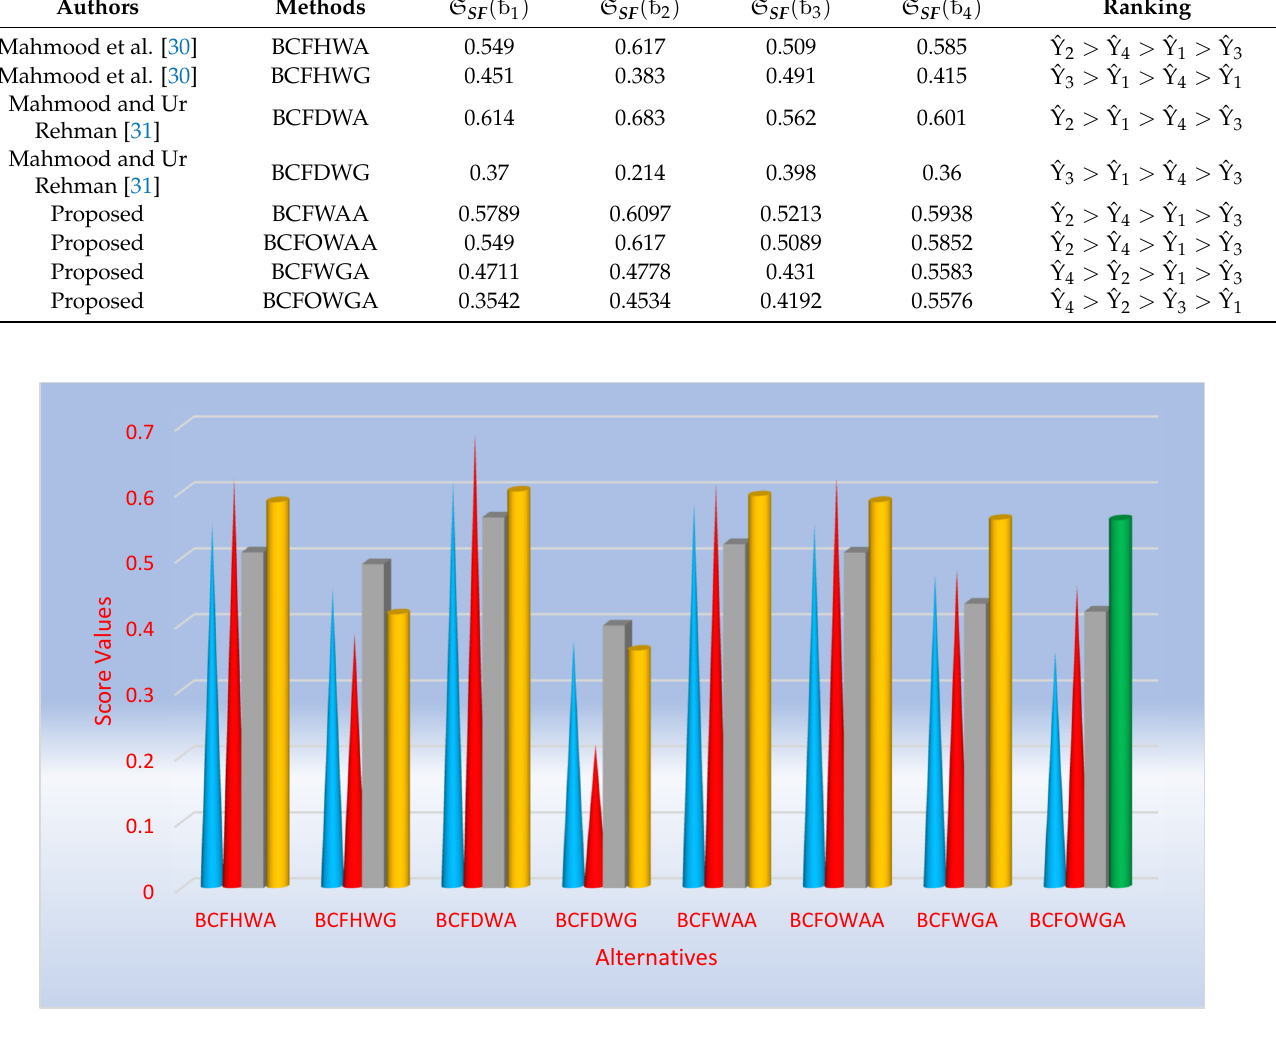
Figure 4. A graphical depiction comparison among proposed and prevailing scenarios. Where, BCFHWA, BCFHWG are presented by Mahmood et al. [30] and BCFDWA, BCFDWG are presented by Mahmood and Ur Rehman [31].